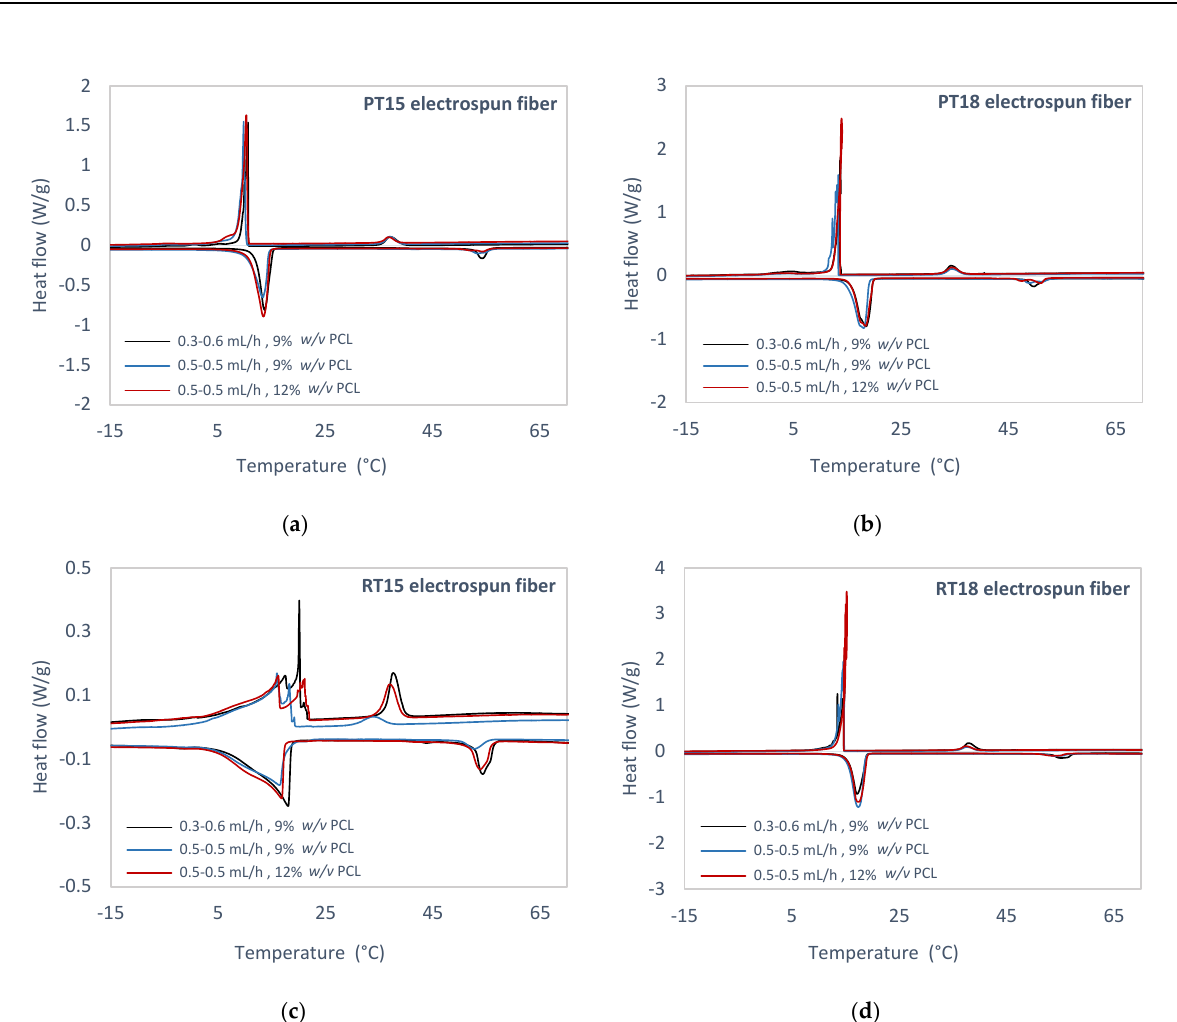
Figure 5. DSC thermogram of ( a ) PT15, ( b ) PT18, ( c ) RT15, and ( d ) RT18 in PCL shell electrospun fiber in 1st thermal cycle. Table 4. DSC results for electrospun PCM fibers of PT15, PT18, RT15, and RT18 in the 1st thermal cycle. PCM Case